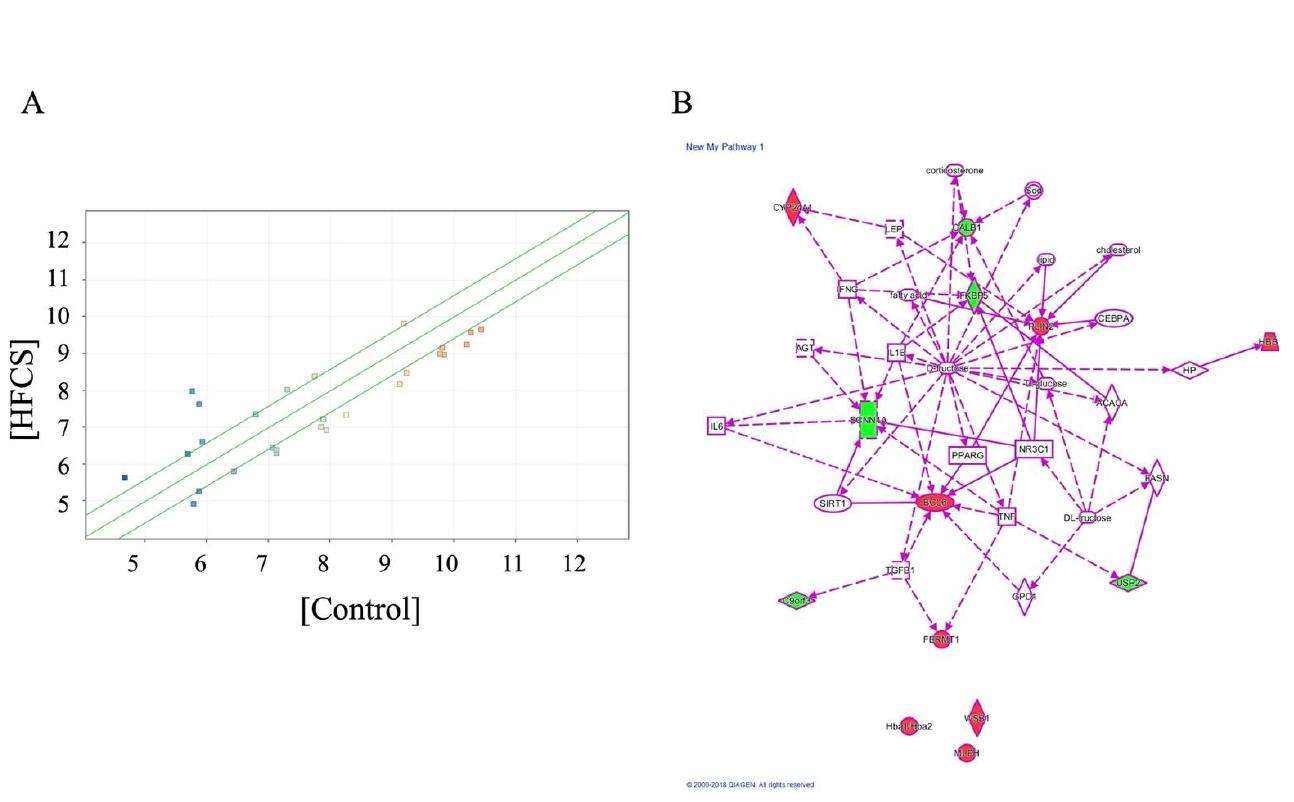
Figure 3. Analysis of high-fructose corn syrup (HFCS)-induced genes in the kidneys. ( A ) Volcano plot of HFCS-induced genes in the kidney, detected by DNA microarray analysis in the HFCS versus control group. The red dots indicate high gene expression levels, while the blue dots indicate low gene expression levels. (fold change >1.5; p < 0.05 by t -test). ( B ) Ingenuity pathway analysis-identified HFCS-induced gene network.